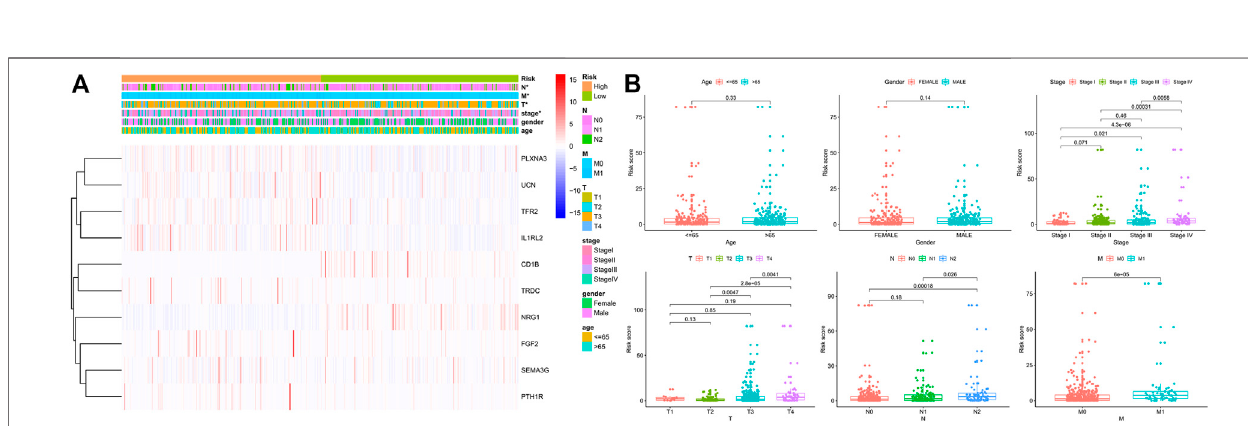
FIGURE5| PrognosticvalueoftheIRGsignatureinexternalvalidationcohort. (A) Kaplan – Meiersurvivalcurve, (B) riskplot,and (C) ROCcurveoftheIRGsignature in the GEO cohort.